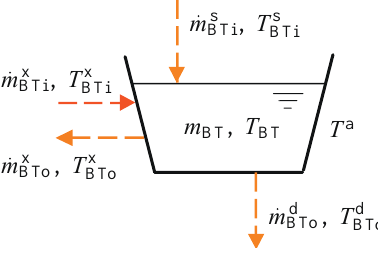
Figure A5. Model for bathtub.